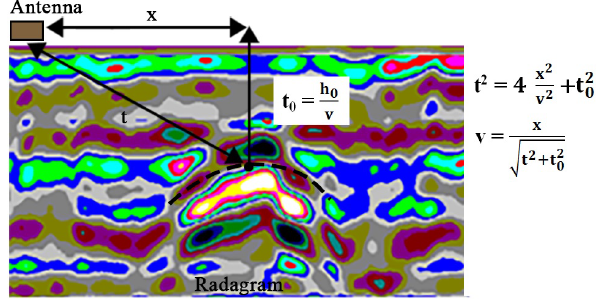
Figure 4. A 400MHz antenna radargram along Profile 4002. The white rectangle along the radargram at approximate depth of 0.6m may correspond to buried wall.